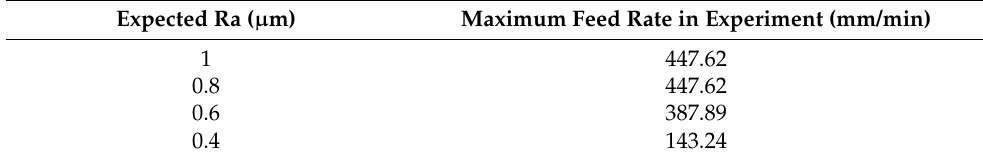
Table 9. Verification of experimental result for feed rate